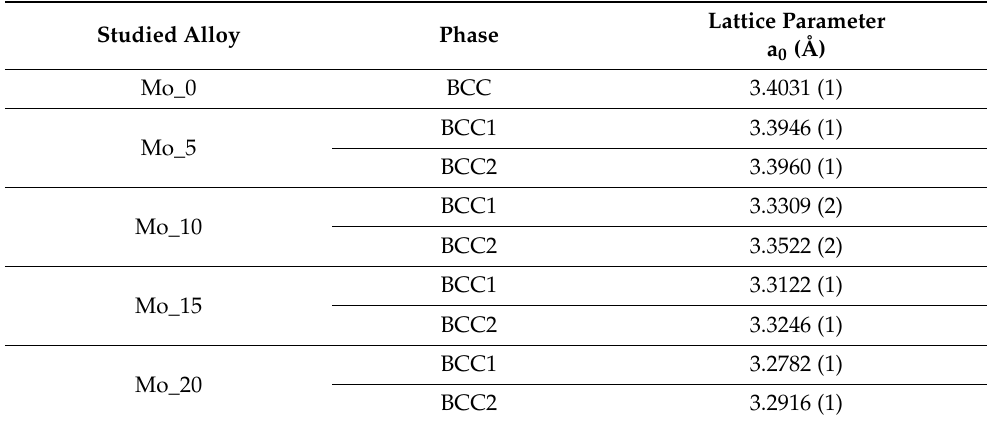
Table 3. Unit cell parameters calculated from X-ray diffraction patterns after Powley refinement.